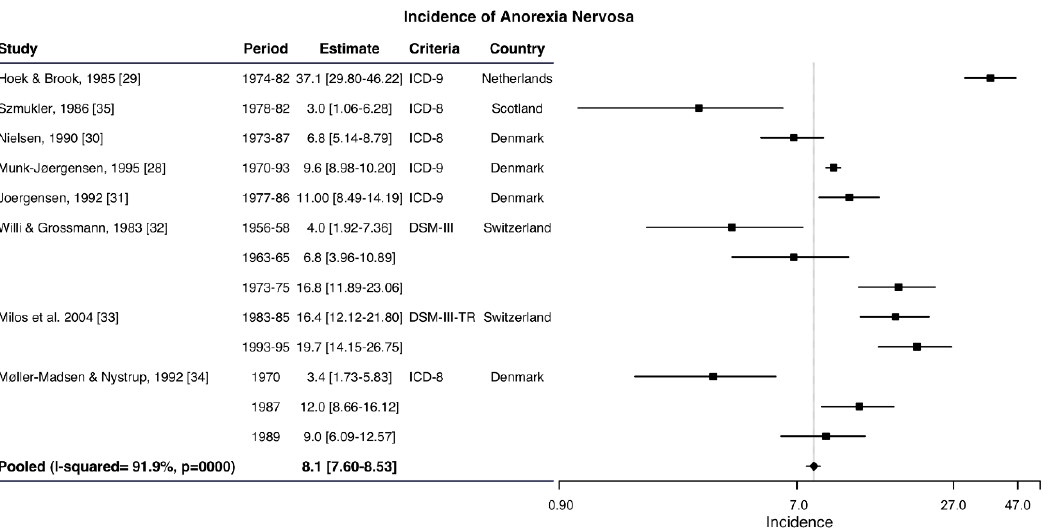
Figure 3. Forest plot of the meta-analysis of the anorexia nervosa incidence rates in young women in hospital admissions.